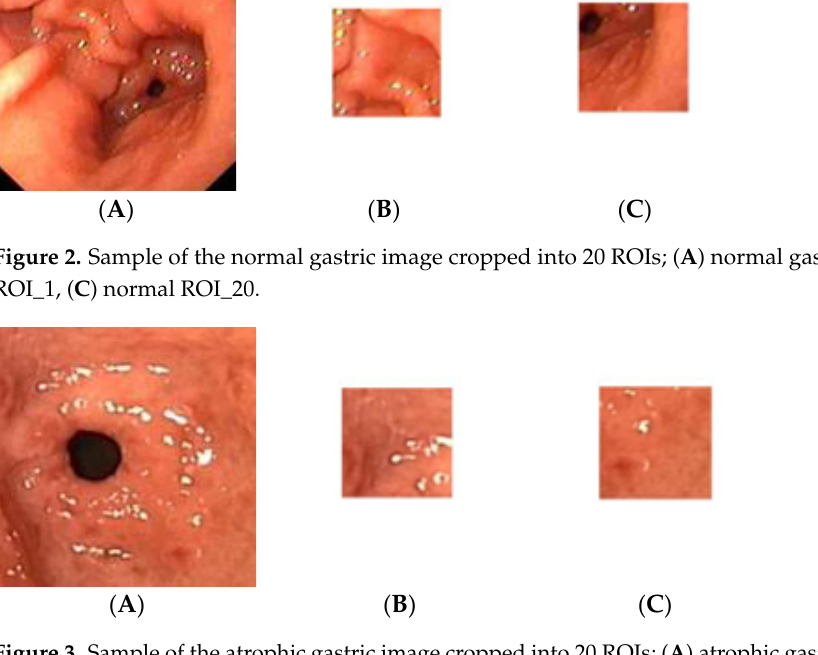
Figure 3. Sample of the atrophic gastric image cropped into 20 ROIs; ( A ) atrophic gastric, ( B ) atrophic ROI_1, ( C ) atrophic ROI_20.